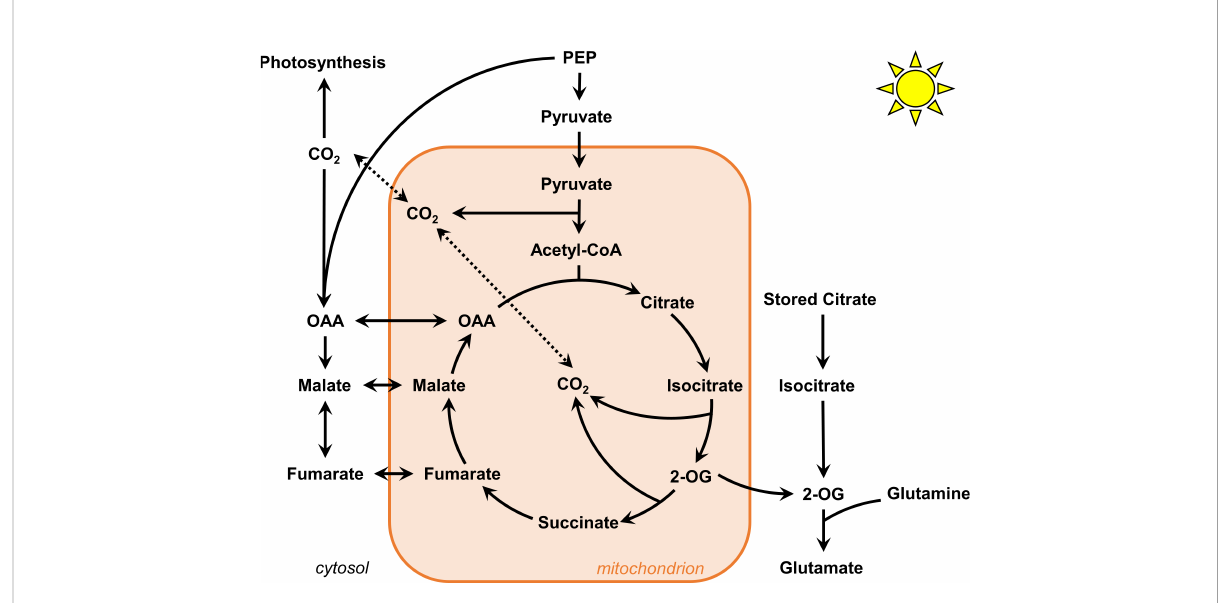
FIGURE 8 Proposed fl ux modes for TCA cycle in B. napus leaves under light conditions. The contribution of stored citrate is unlikely to interact with mitochondrial TCA cycle. The mitochondrial TCA cycle operate in both cyclic and non-cyclic fl ux modes. To which extent 2-oxoglutarate molecules escape the cycle and imbalance this cyclic/non-cyclic ratio remain to be